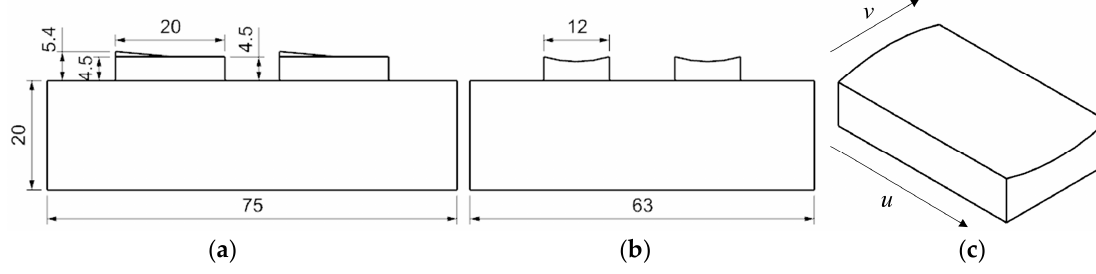
Figure 3. Design of Surface two; ( a ) front view; ( b ) side view; ( c ) isometric view.